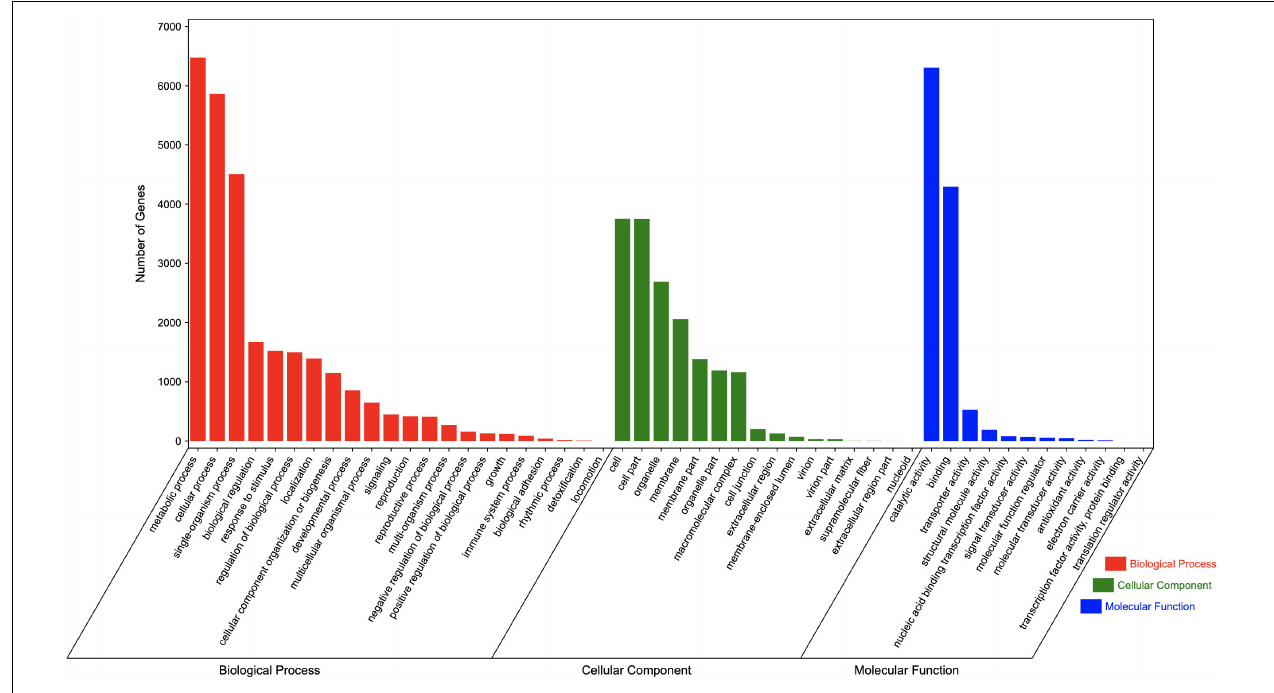
FIGURE 4 | GO terms assigned to Chrysanthemum dichrum